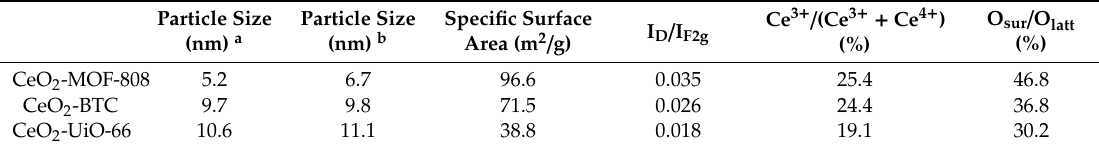
Table 2. The surface properties and catalytic performance of CeO 2